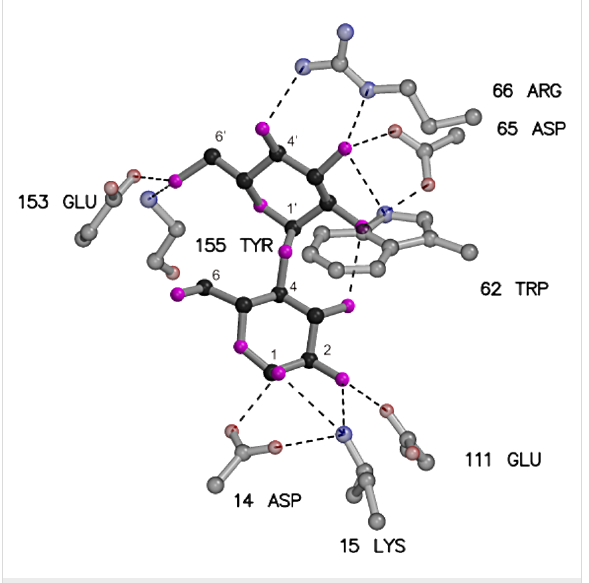
Figure 1: Schematic diagram of the network of hydrogen bonds in the binding pocket of the complex between MBP and maltose (PDB ID code 1ANF); hydrogen bonds are shown as dashed